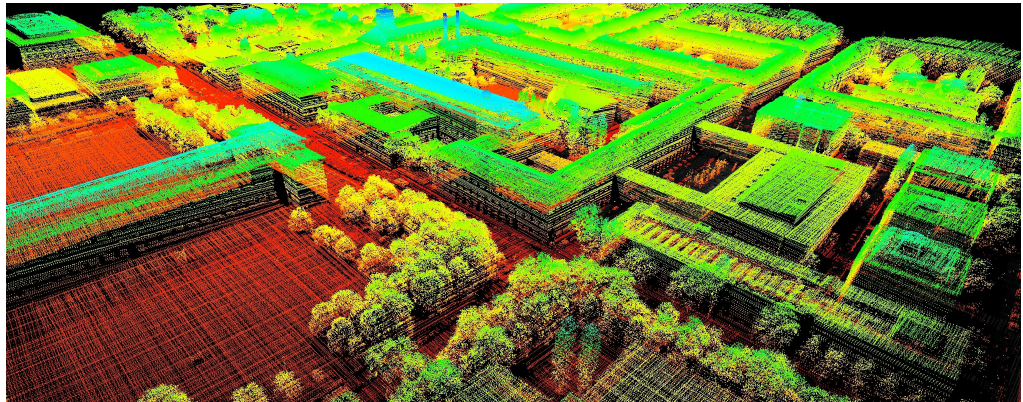
Figure 1. Point cloud from multi-aspect oblique airborne laser scanning (height coded by colour)